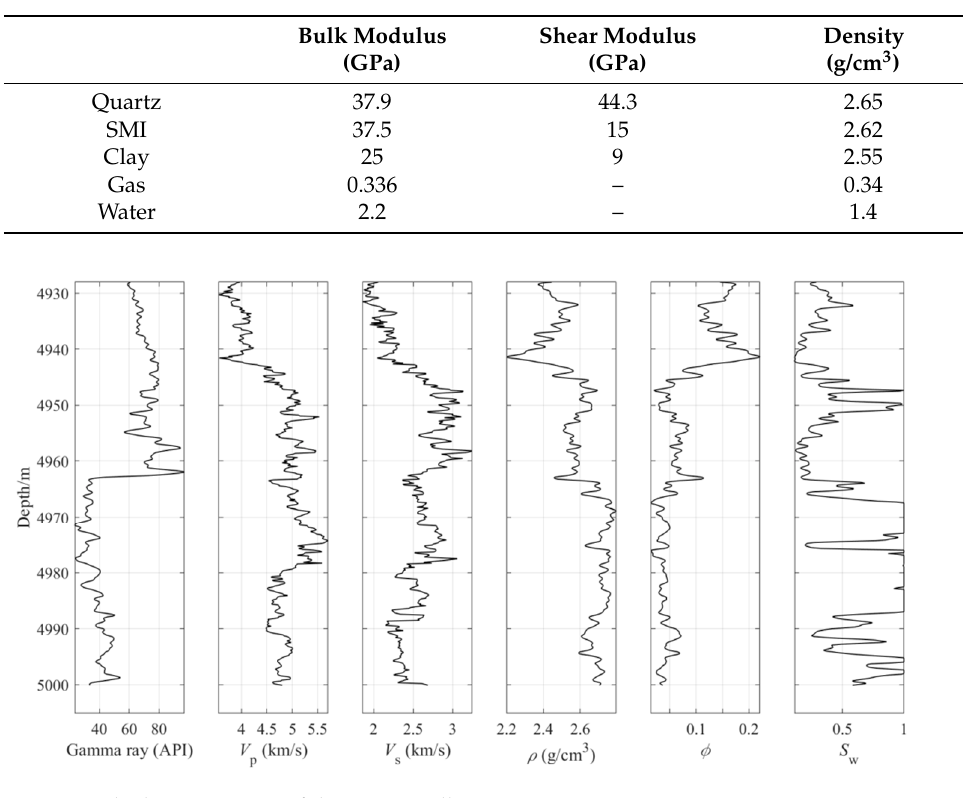
Figure 3. The logging curve of the target well section. Table 1. The modulus and density of mineral and pore fluids [43 ].